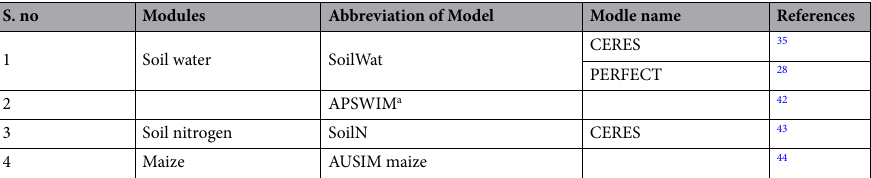
Table 1. List of APSIM Modules used in the study and simulate in the nitrogen model. Intellectual property remains that of the original developer. APSWIM (APSIM-Soil water infiltration and movement) it measures soil water behavior in APSIM. a Four modules, a soil–water module (SOILWAT2), the soil nitrogen module (SOILN2) and the fertilizer module (FERTILIZ), and a specific crop module (APSIM-maize).